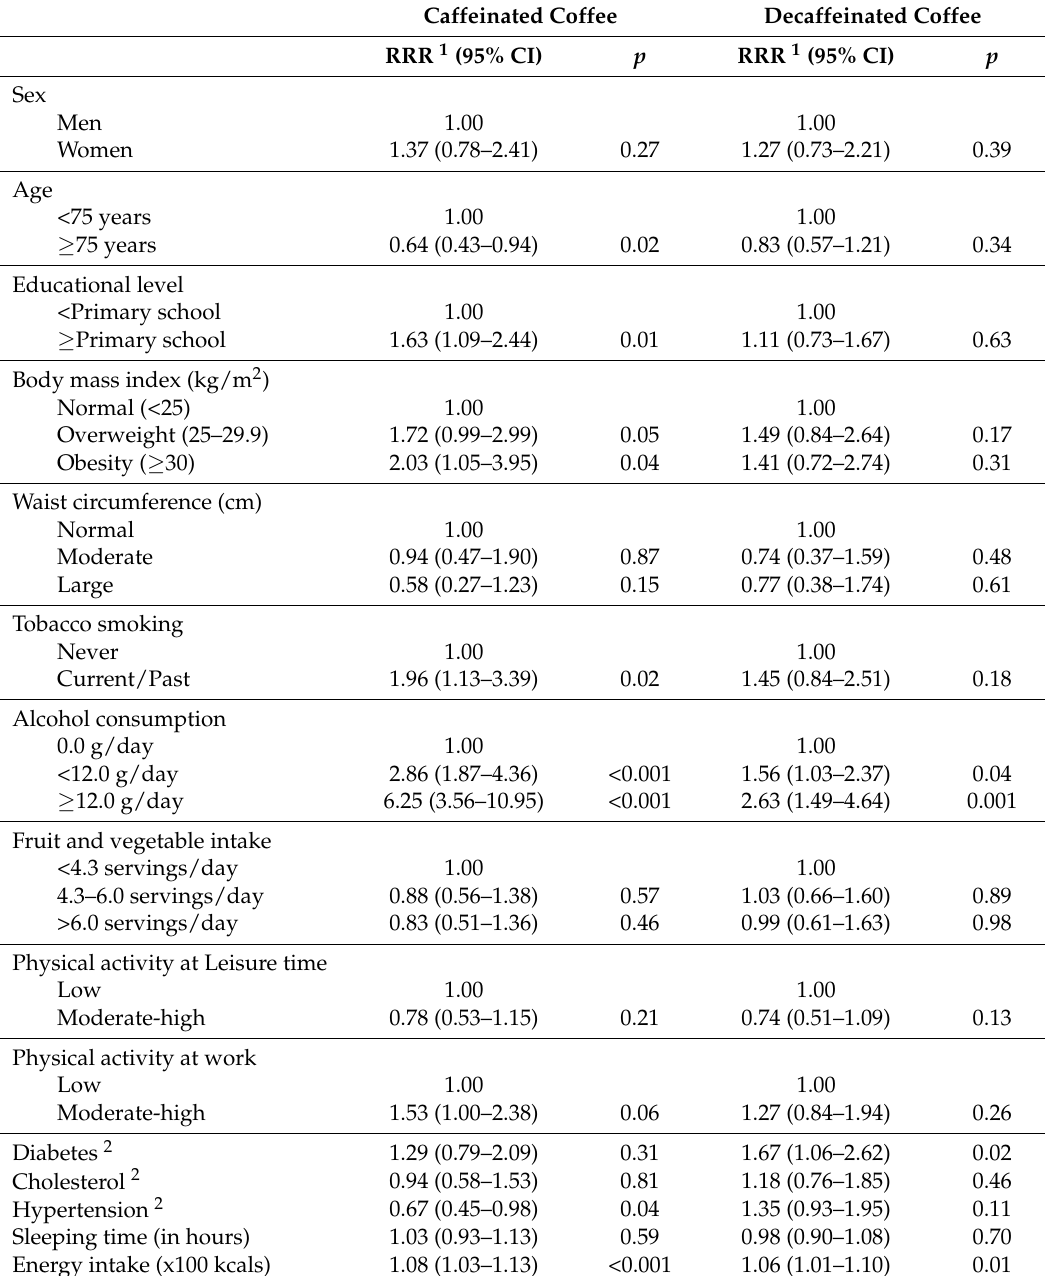
Table 2. Associated factors with coffee consumption (caffeinated and decaffeinated) in elderly population, aged 65 years and above, from the EUREYE-Spain Study and the Valencia Nutrition Survey in